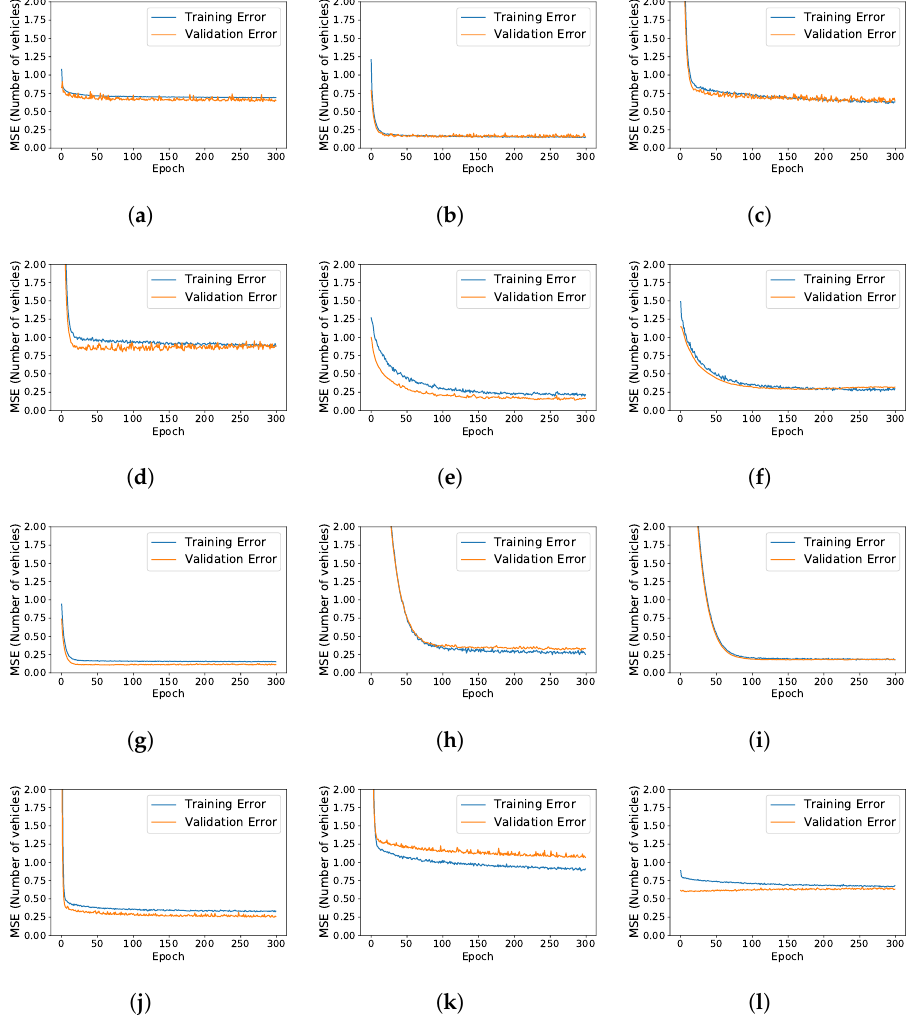
Figure A1. Training and validation results for all the built models. ( a ) Aggregated Model; ( b ) Q-Q model; ( c ) Q-S model; ( d ) Q-F model; ( e ) S-S model; ( f ) S-F model; ( g ) F-F model model; ( h ) S-Q model; ( i ) F-SQ Model; ( j ) Q model; ( k ) S model; ( l ) F